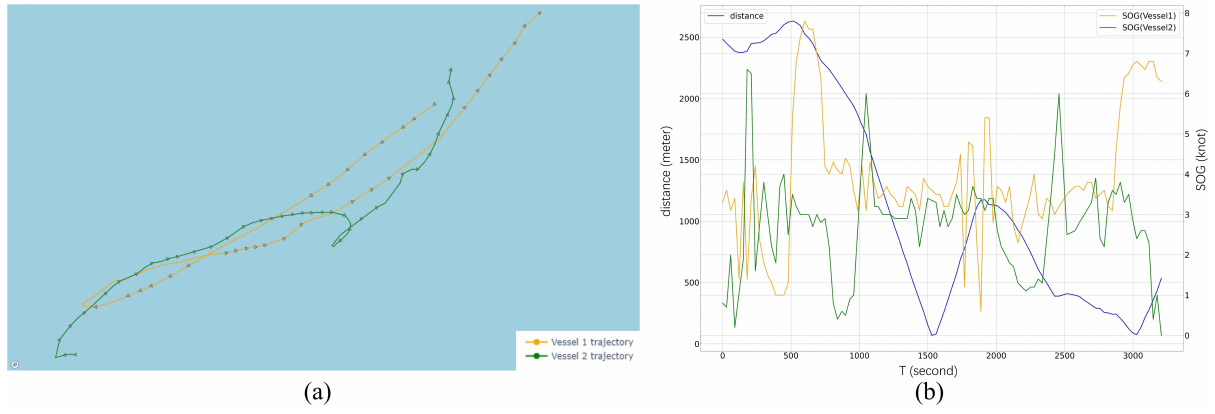
Figure 7. Highly suspicious events not identified by fixed threshold methods: ( a ) Trajectories of the involved vessels; ( b ) Change of distance and speed during the event.